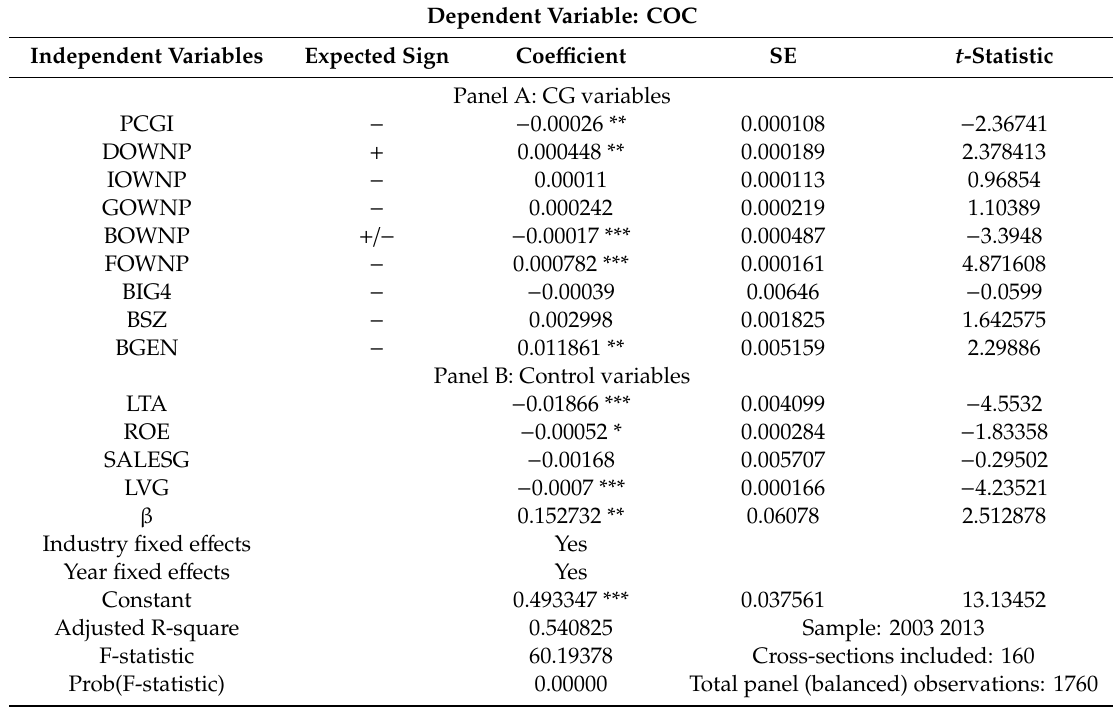
Table 2. The ordinary least squares (OLS) regression of CG and